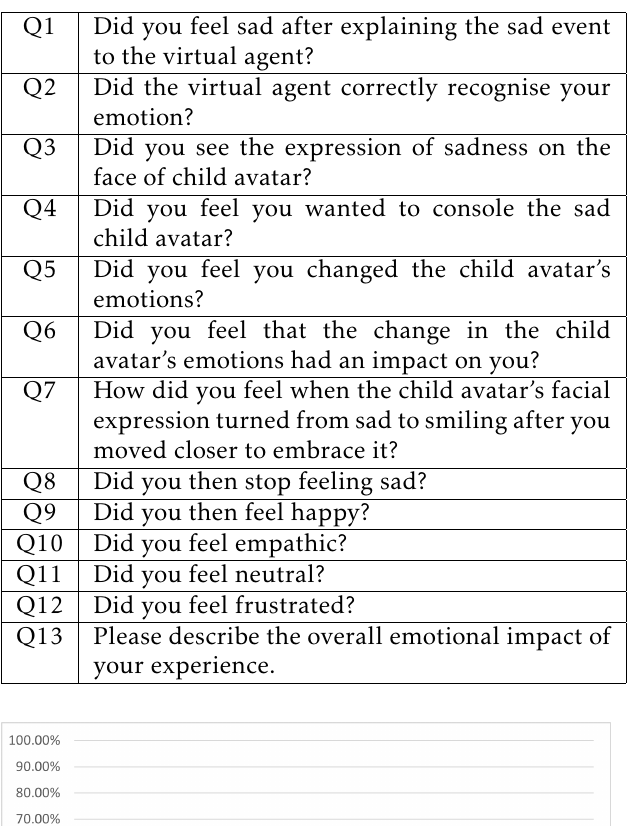
Table 4. Likert scale (N=5) questionnaire: Trial with generic child avatar.